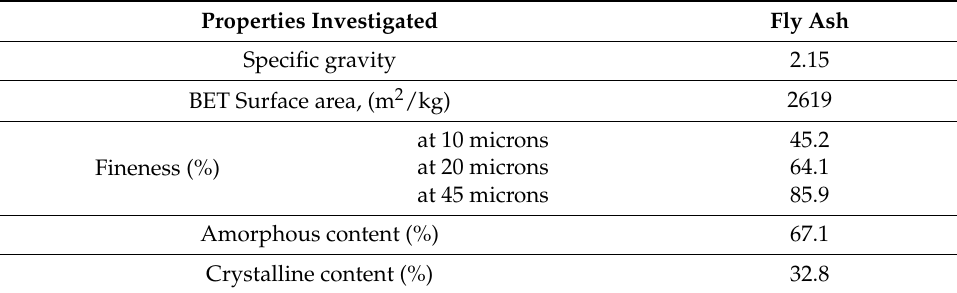
Table 6. Physical and mineralogical properties of high calcium fly